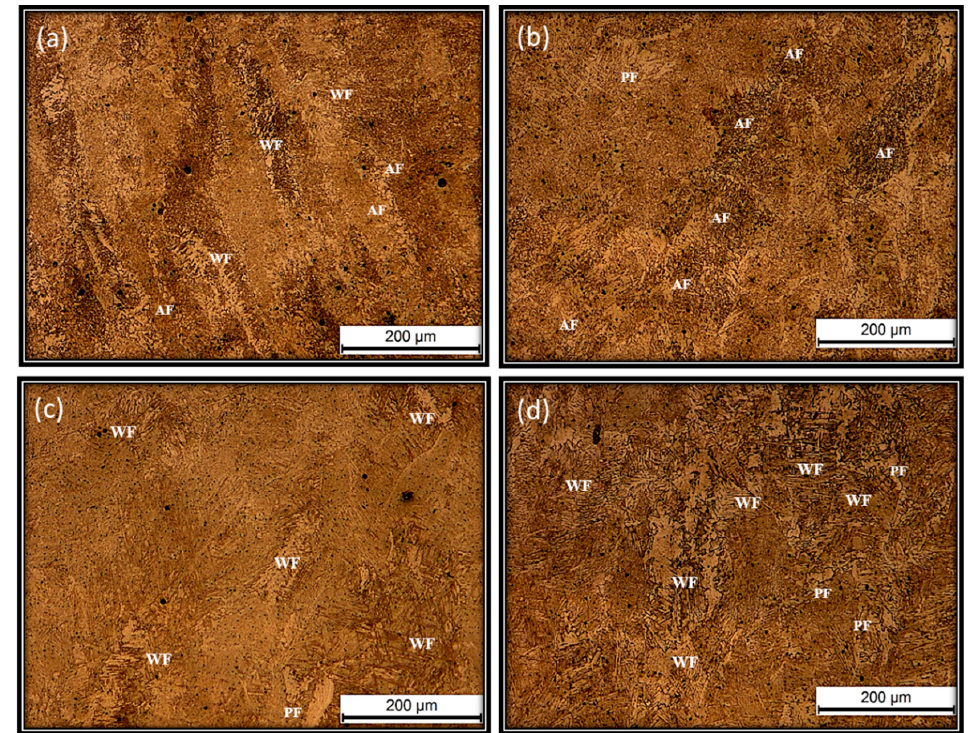
Figure 14. OM images for WAAM-ed prismatic built blocks at ( a , c ) Block 130; ( b , d ) Block 330 for the DZ-1 and 4th deposited layers, respectively.